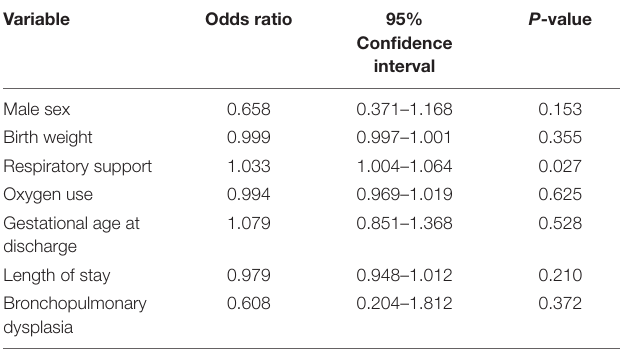
TABLE 2 | Parameter estimates from multivariable logistic regression.